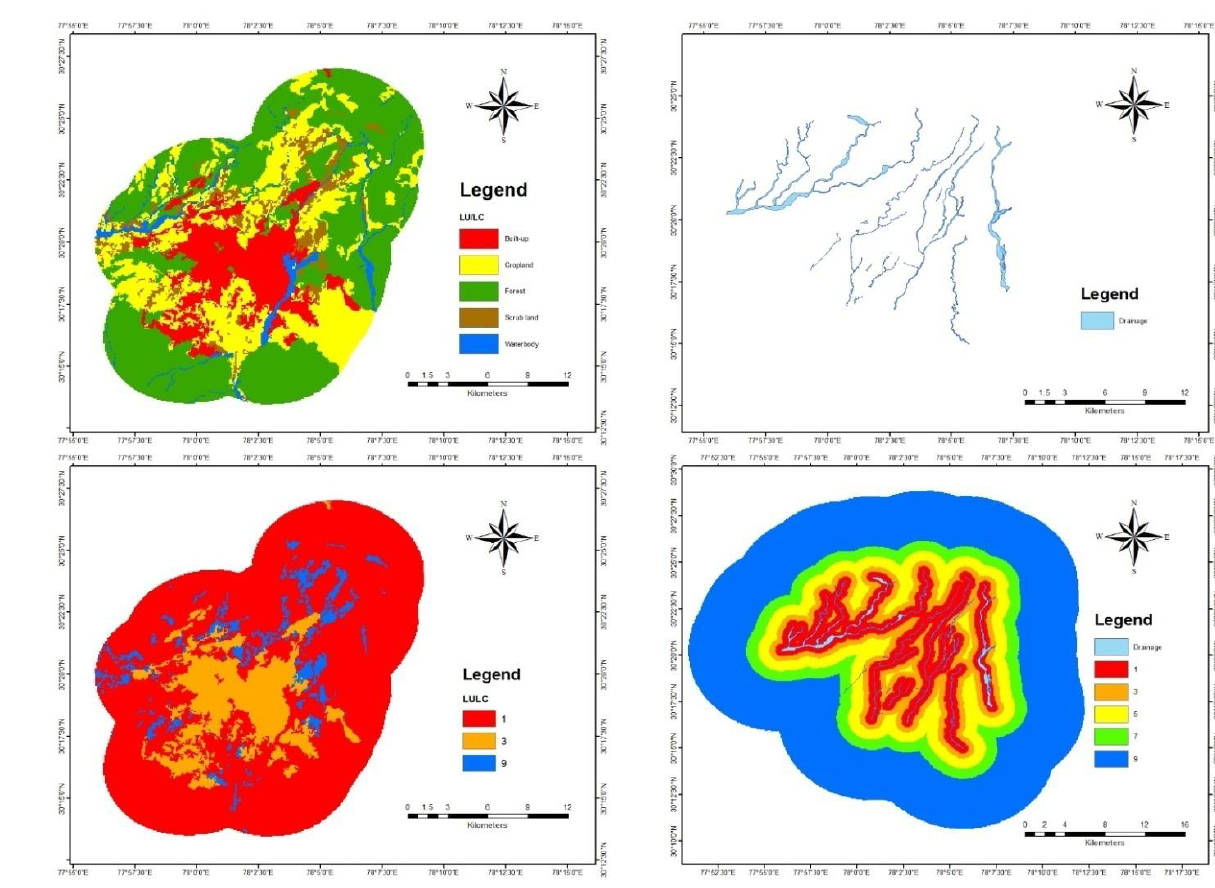
Figure 7. LU/LC suitability map